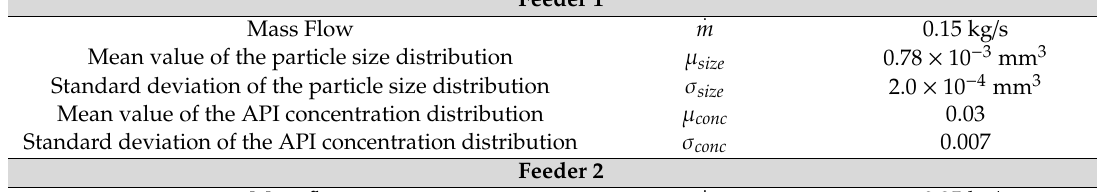
Table 4. Model parameters used for coupled agglomeration and breakage process.